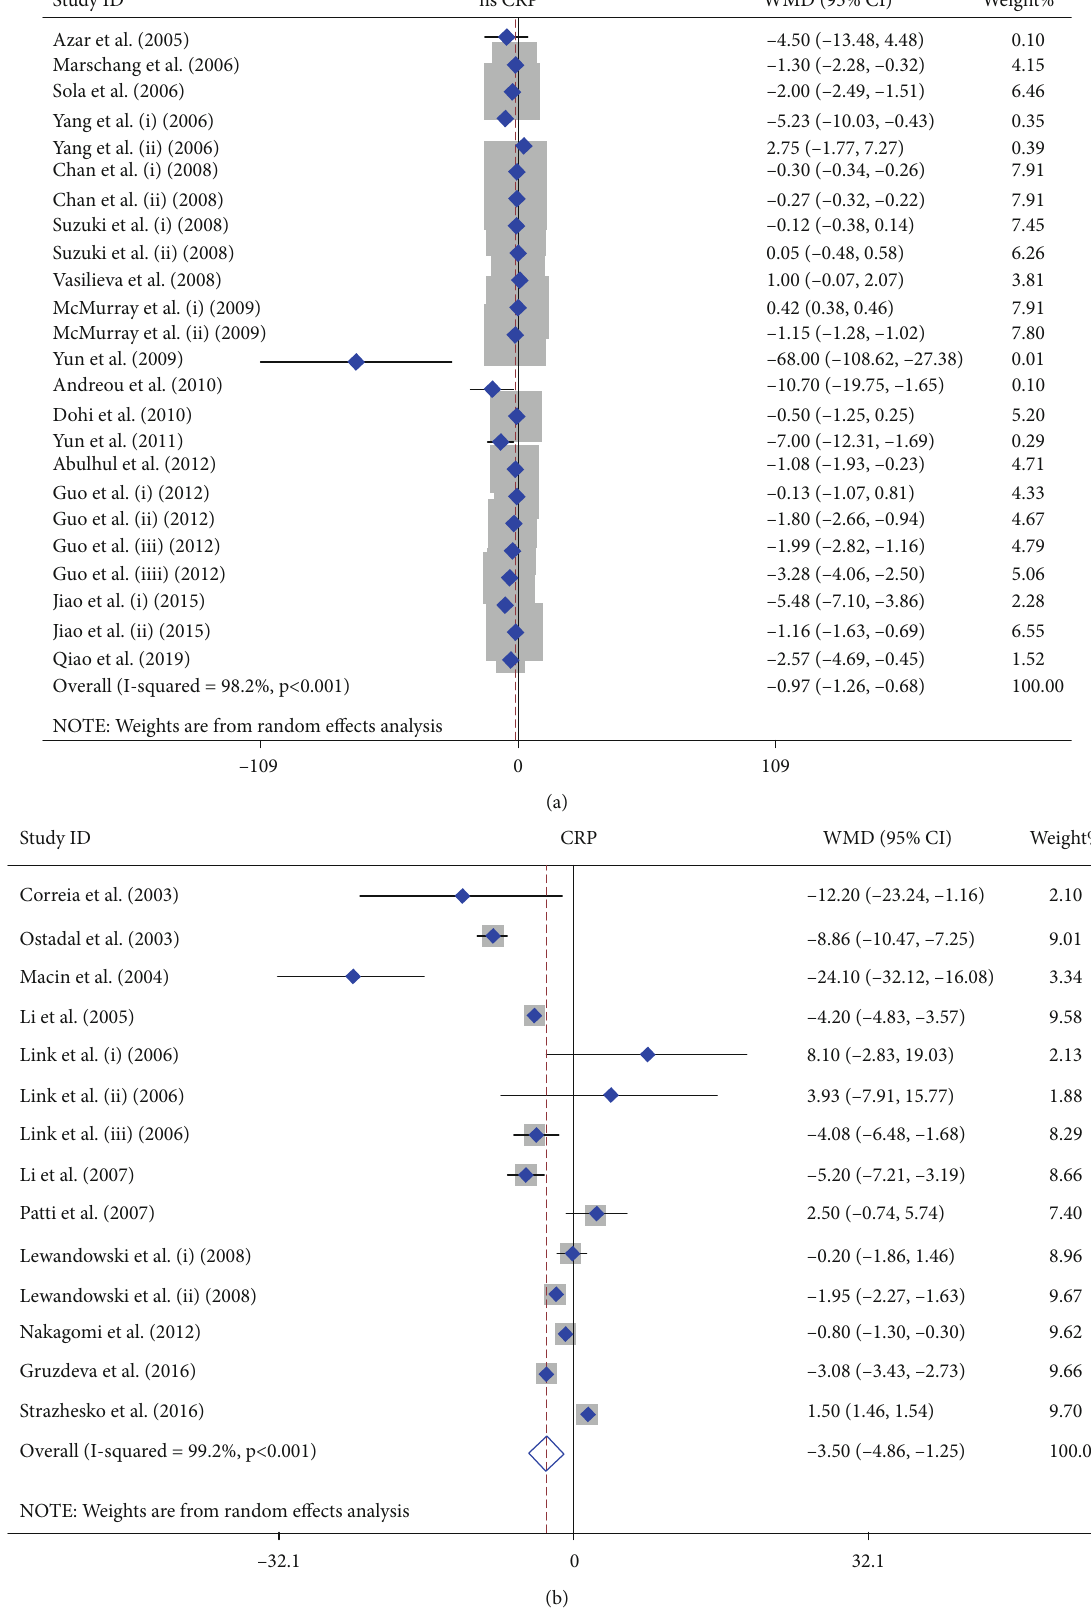
Figure 2: Forest plot presenting WMD and 95% CI for the e ff ect of statin administration on hs-CRP (a) and CRP (b) levels in the overall